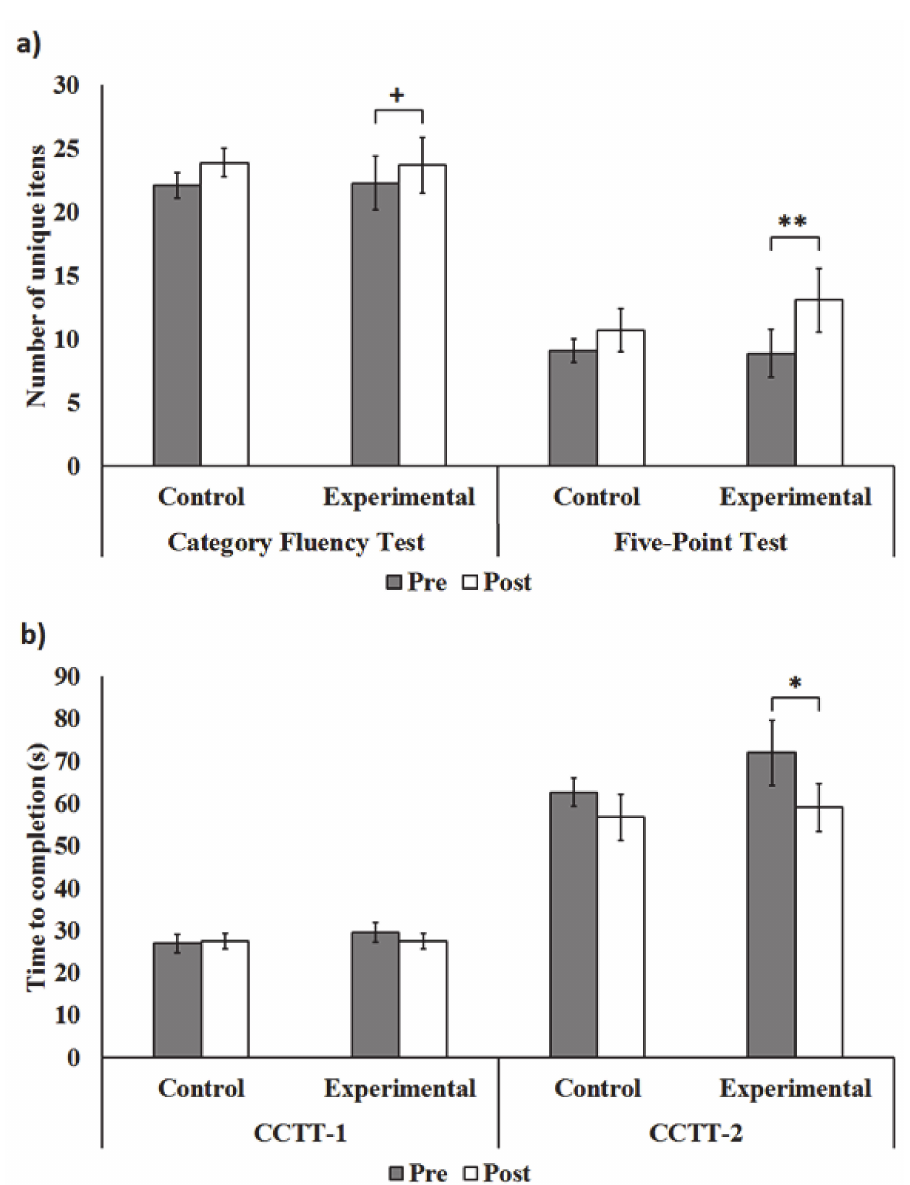
Figure 2. Performance in the ( a ) Category Fluency Test and Five-Point Test, in addition to the ( b ) Children’s Color Trails Test (CCTT) in the experimental ( n = 16) and control ( n = 16) groups. “Pre” and “Post” refer to the test performance of participants before and after real training/no training period, respectively. Error bars represent 1 standard error ± the mean. Asterisks indicate the level of significance of paired t -tests (two-tailed). ** p < 0.01, * p < 0.05, + p =